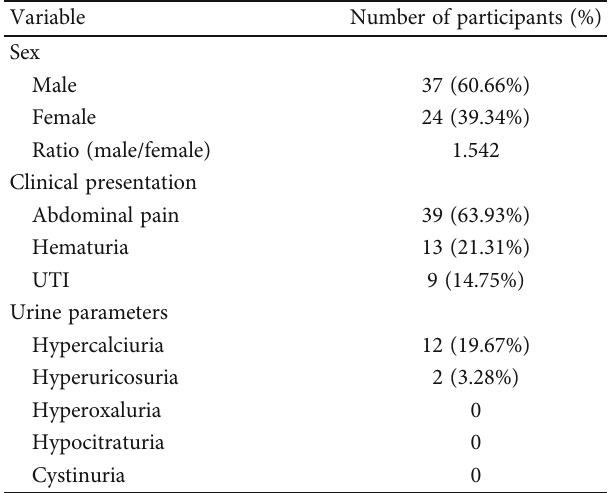
Table 1: Data on the demographic and clinical features of the study participants ( n = 61